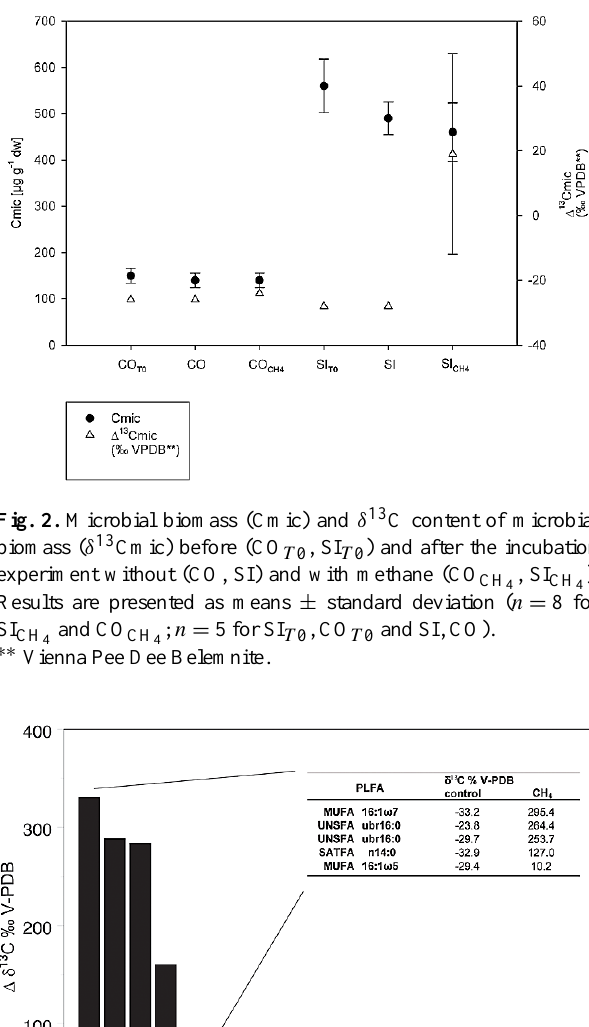
, SI CH ). Differ- 4 4